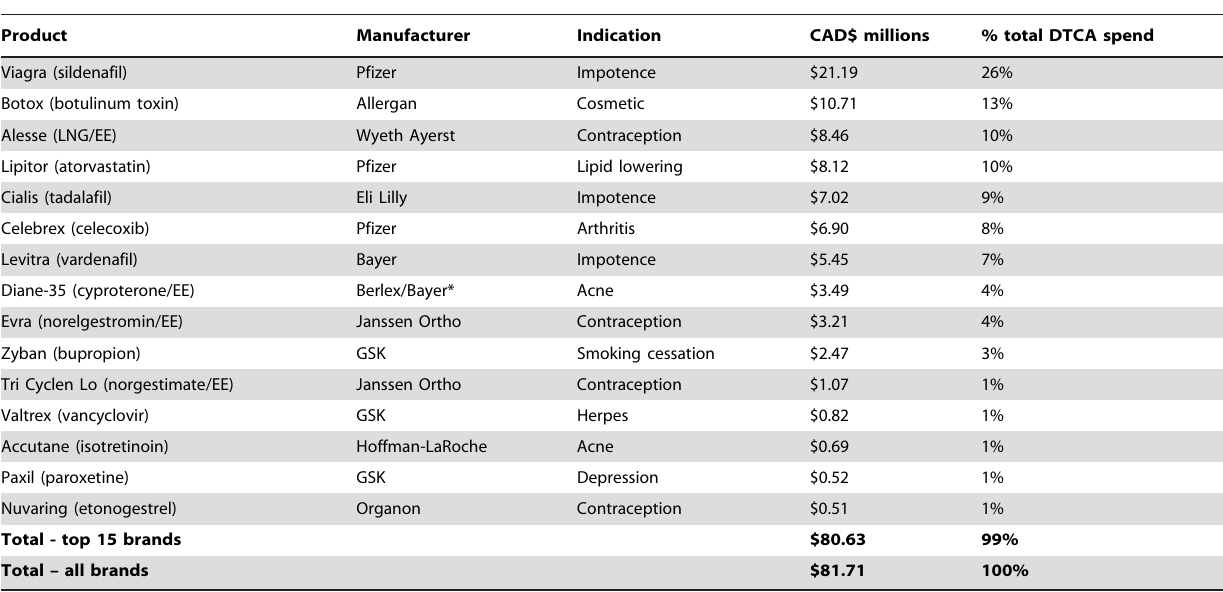
Table 2. Top 15 brands by advertising spending, all media,